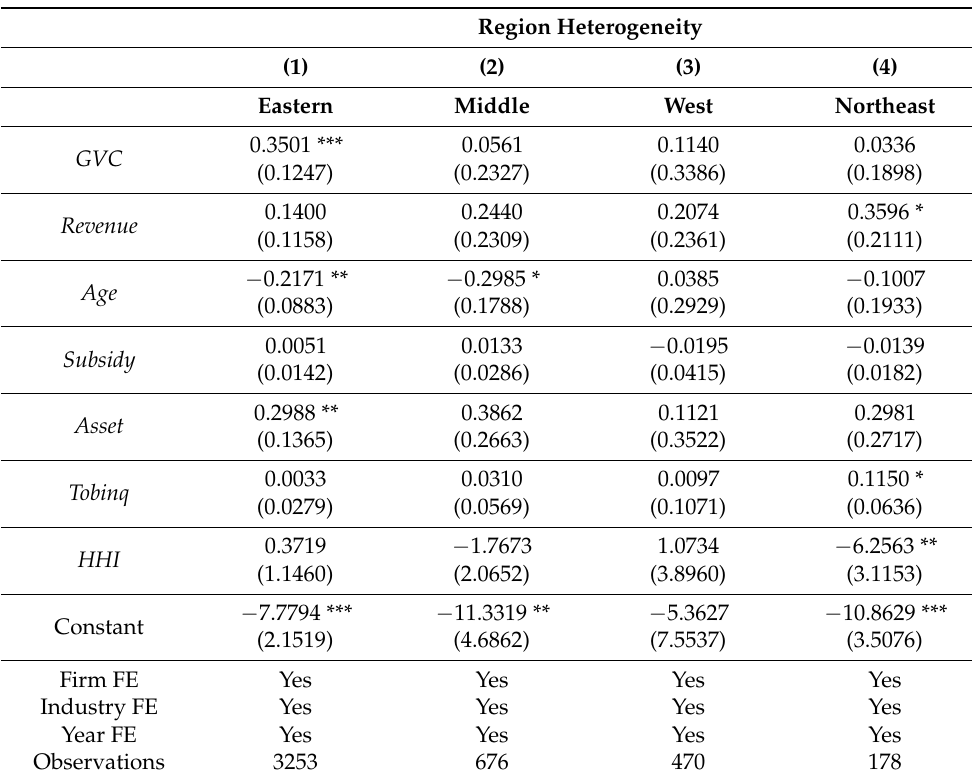
Table 8. Regional heterogeneity